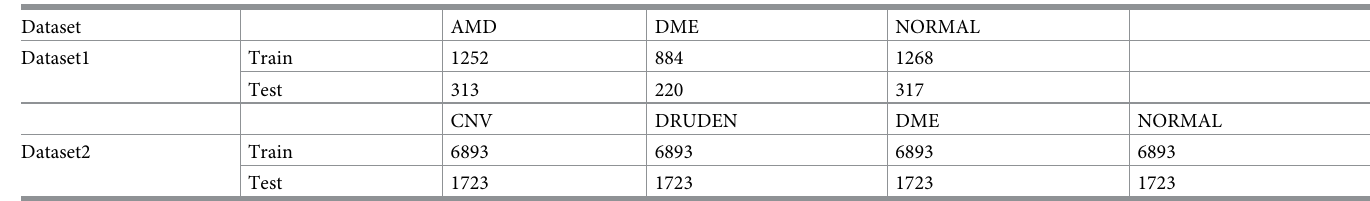
Table 1. Dataset statistics.